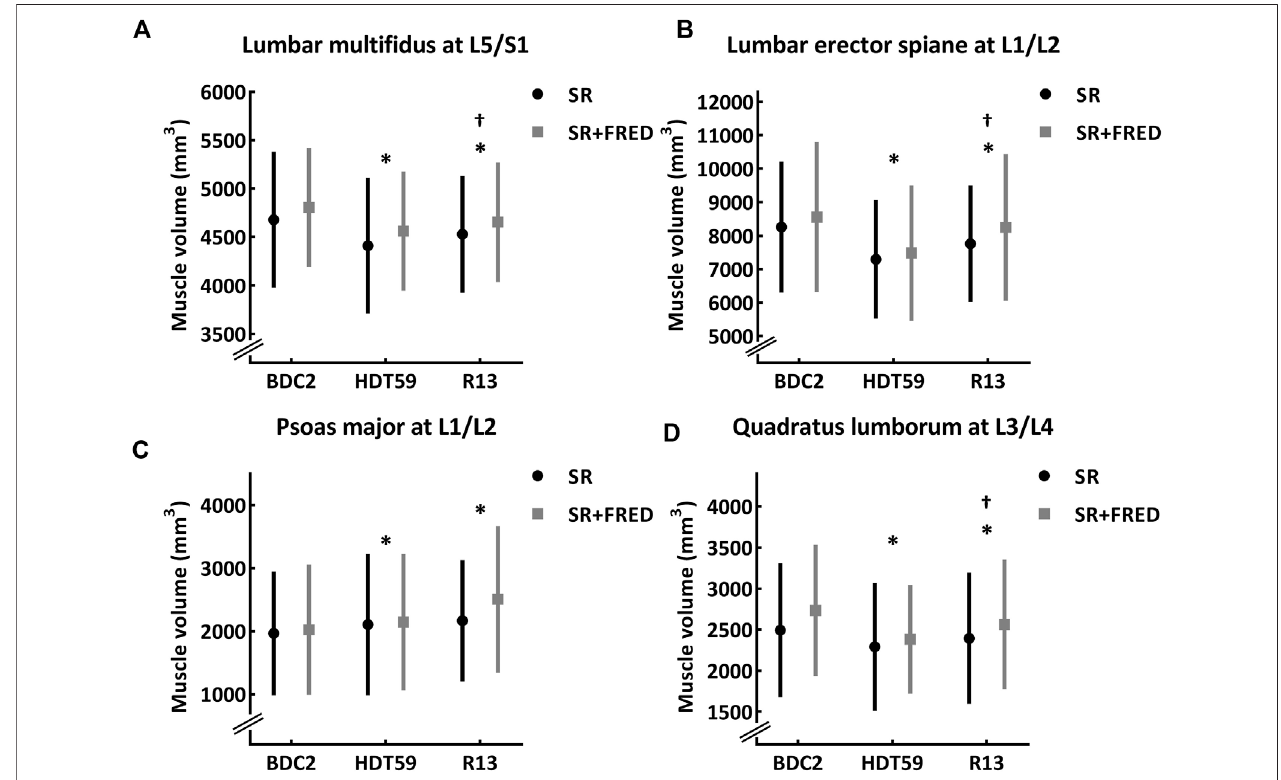
FIGURE2| Morphologyofthelumbarmulti fi dus,lumbarerectorspinae,psoasmajor,andquadratuslumborummusclesat2 daysbeforethebeginningofthebed rest period (BDC2), day 59 of head-down tilt bed rest (HDT59), and day 13 of recovery period (R13) for participants in the Standard Reconditioning (SR, n = 12) and StandardReconditioningsupplementedwithFunctionalRe-adaptiveExerciseDevice(SR+FRED, n =12).TheblacklineisSRgroupandthelightgraylineisSR+FRED group. The group means are a fi lled circle (SR group) or a fi lled square (SR + FRED group), and the vertical line is the standard deviation. (A) Muscle volume of the lumbarmulti fi dusatL5/S1. (B) MusclevolumeofthelumbarerectorspinaeatL1/L2. (C) MusclevolumeofthepsoasmajoratL1/L2. (D) Musclevolumeofthequadratus lumborum. The group means are a fi lled circle (SR group), and the vertical line is the standard deviation. *Signi fi cantly different from BDC2 within the group ( p < 0.05). † Signi fi cantly different from HDT59 within the group ( p < 0.05). SR, Standard Reconditioning; SR + FRED, Standard Reconditioning supplemented with Functional Re- adaptive Exercise Device; BDC, Baseline data collection; HDT, Head-down tilt; R,